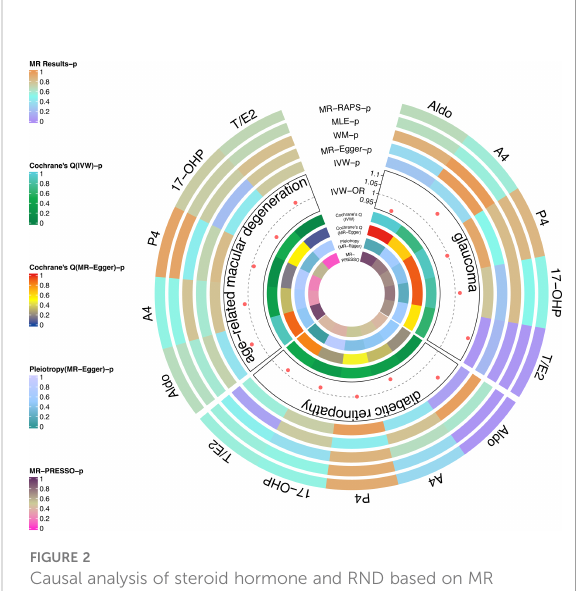
FIGURE 2 Causal analysis of steroid hormone and RND based on MR analyses and sensitivity analyses in the discovery